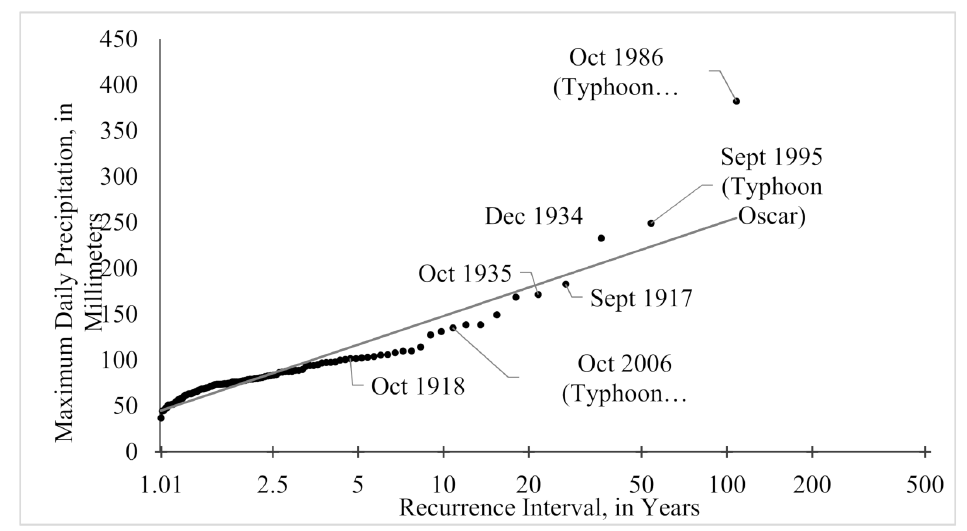
Figure 5. Recurrence Interval of maximum daily total precipitation in Seward for 1908–1925 and 1929–2018, measured in mm.